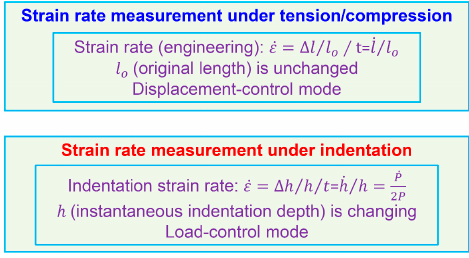
Figure 1. Differences between strain rate sensitivity measurement under tension/compression and nanoindentation. Different from measuring the dimension change of tension and compression specimens, nanoindentation quantifies the strain from a combination of load and indentation depth.